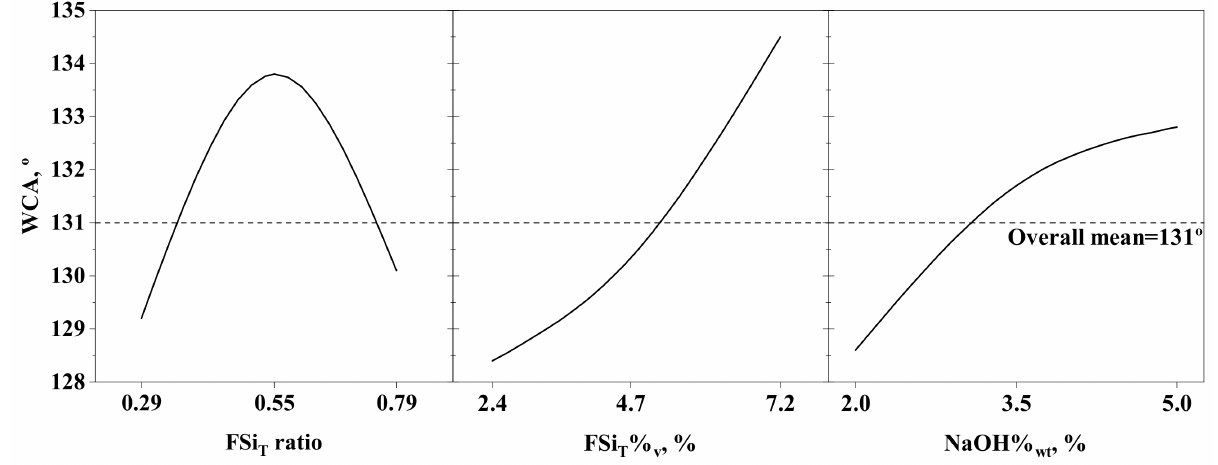
Figure 4. Main-effects plot of the factors analysed in the 3 3 complete factorial design. After determining the main effects of the factors and their interactions with the 3 3 factors. A statistical analysis based on response surface methodology was carried out